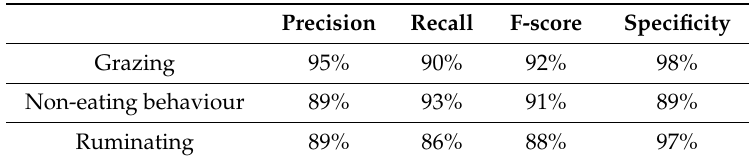
Table 8. Performance of the classification using ear data and 39 features of specific eating behavioural activities based on random